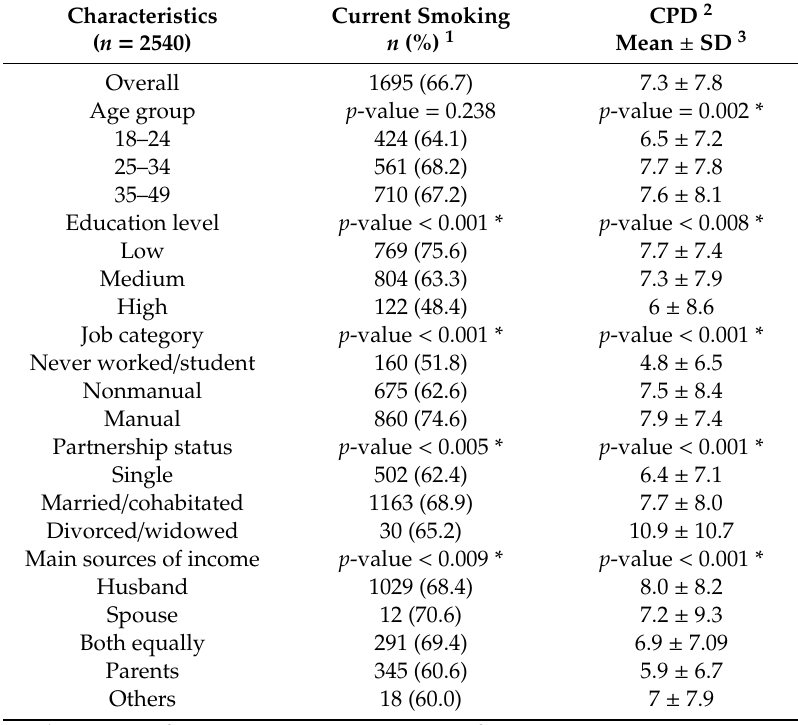
Table 1. Current smoking and cigarettes smoked per day (CPD) by the characteristics of the